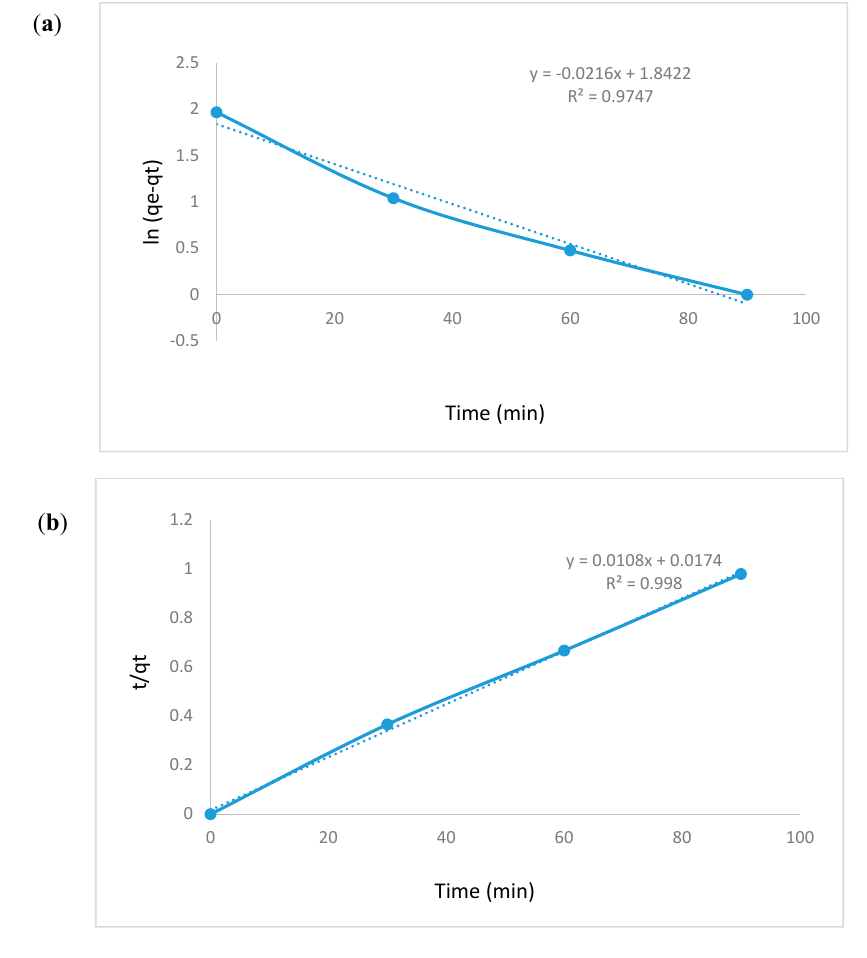
Figure 20. Plots of ( a ) pseudo-first-order ( b ) second-order kinetic models for photocatalytic degradation of methylene blue using Co 0.1 Al 0.03 Fe 0.17 O 0.4.